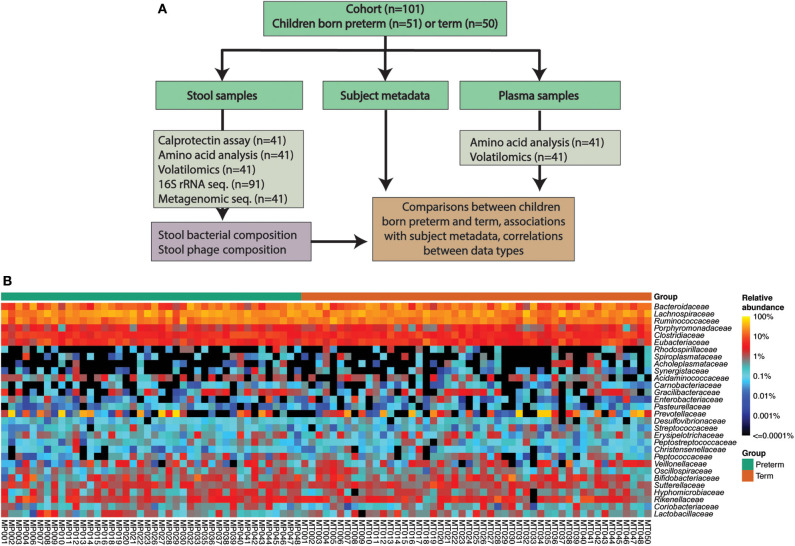
(A) Cohort and data overview. (B) Abundances of the 30 most abundant bacterial families according to the 16S rRNA amplicon sequencing data.